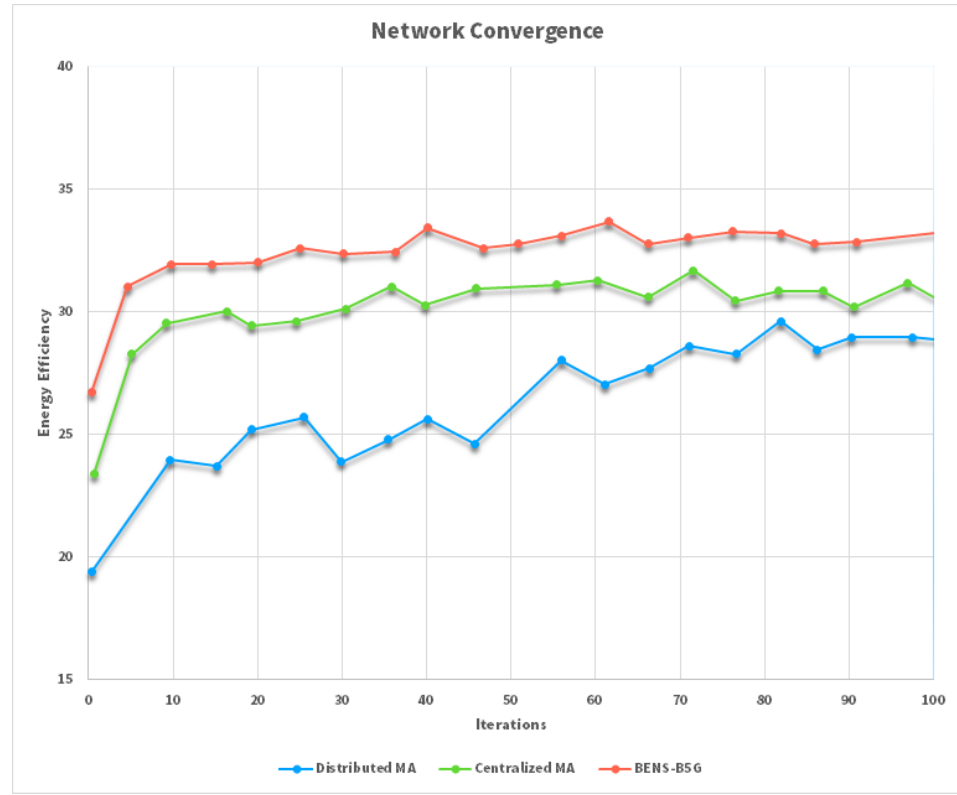
Figure 8. Convergence comparison.